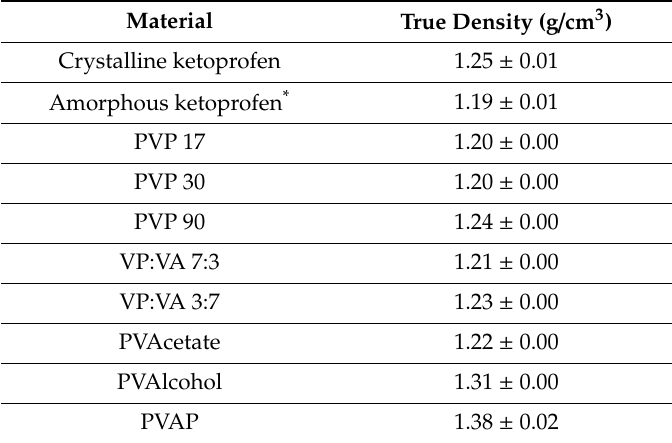
Table 3. True density values of ketoprofen and studied polymers. Values are presented as an average ± standard deviation. * Value determined by reducing the crystalline density by 5%.